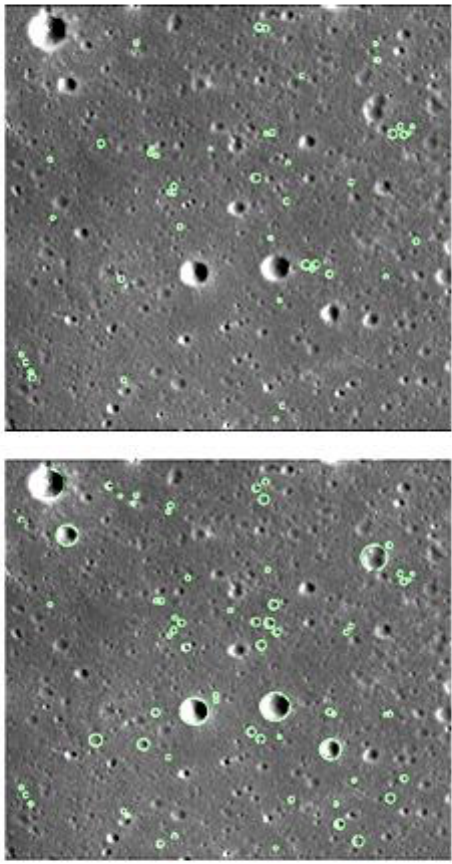
Figure 4. Top: Craters detected in Kaguya TC image data by the SCD algorithm (top) and the binned SCD algorithm (bottom).